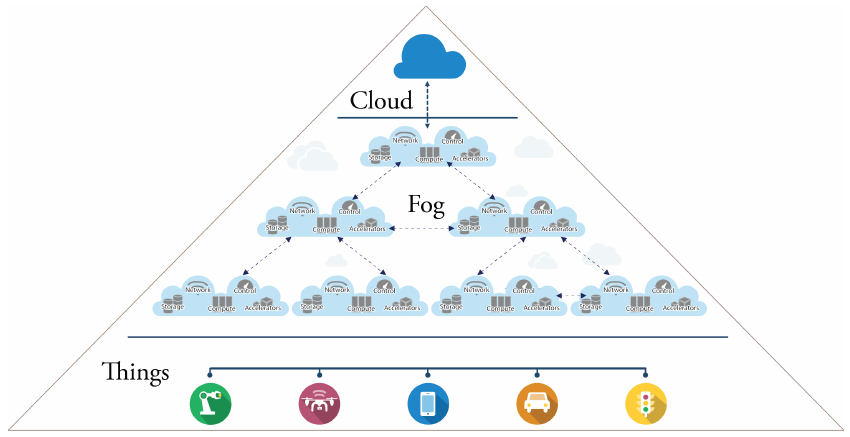
Figure 10. Details regarding the fog